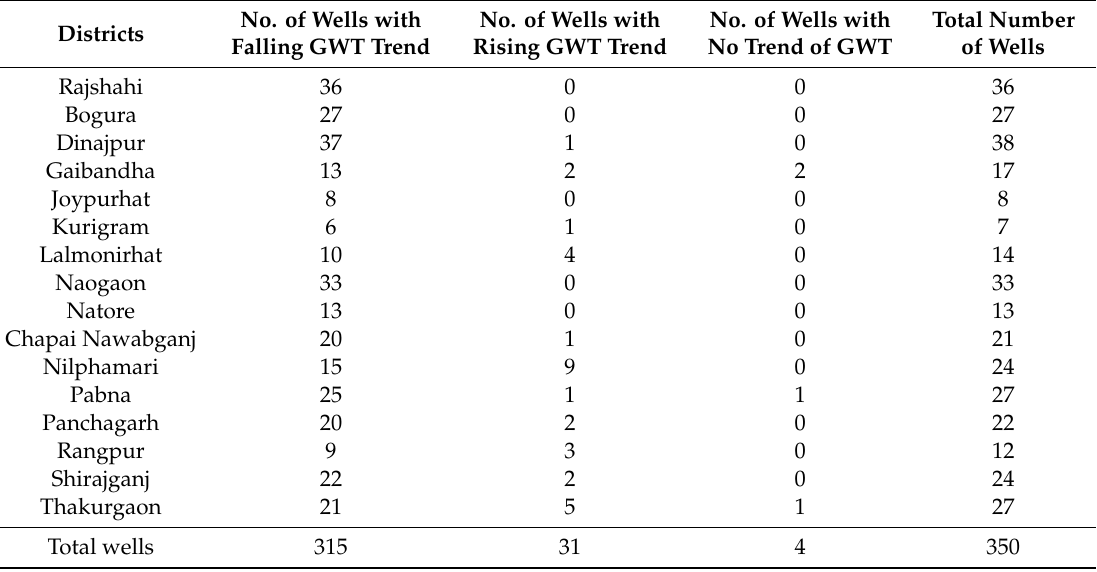
Table 3. Number of groundwater table (GWT) monitoring wells in 16 districts of the North-West hydrological region of Bangladesh with falling, rising, and no trends of the annual minimum depths of GWTs from ground